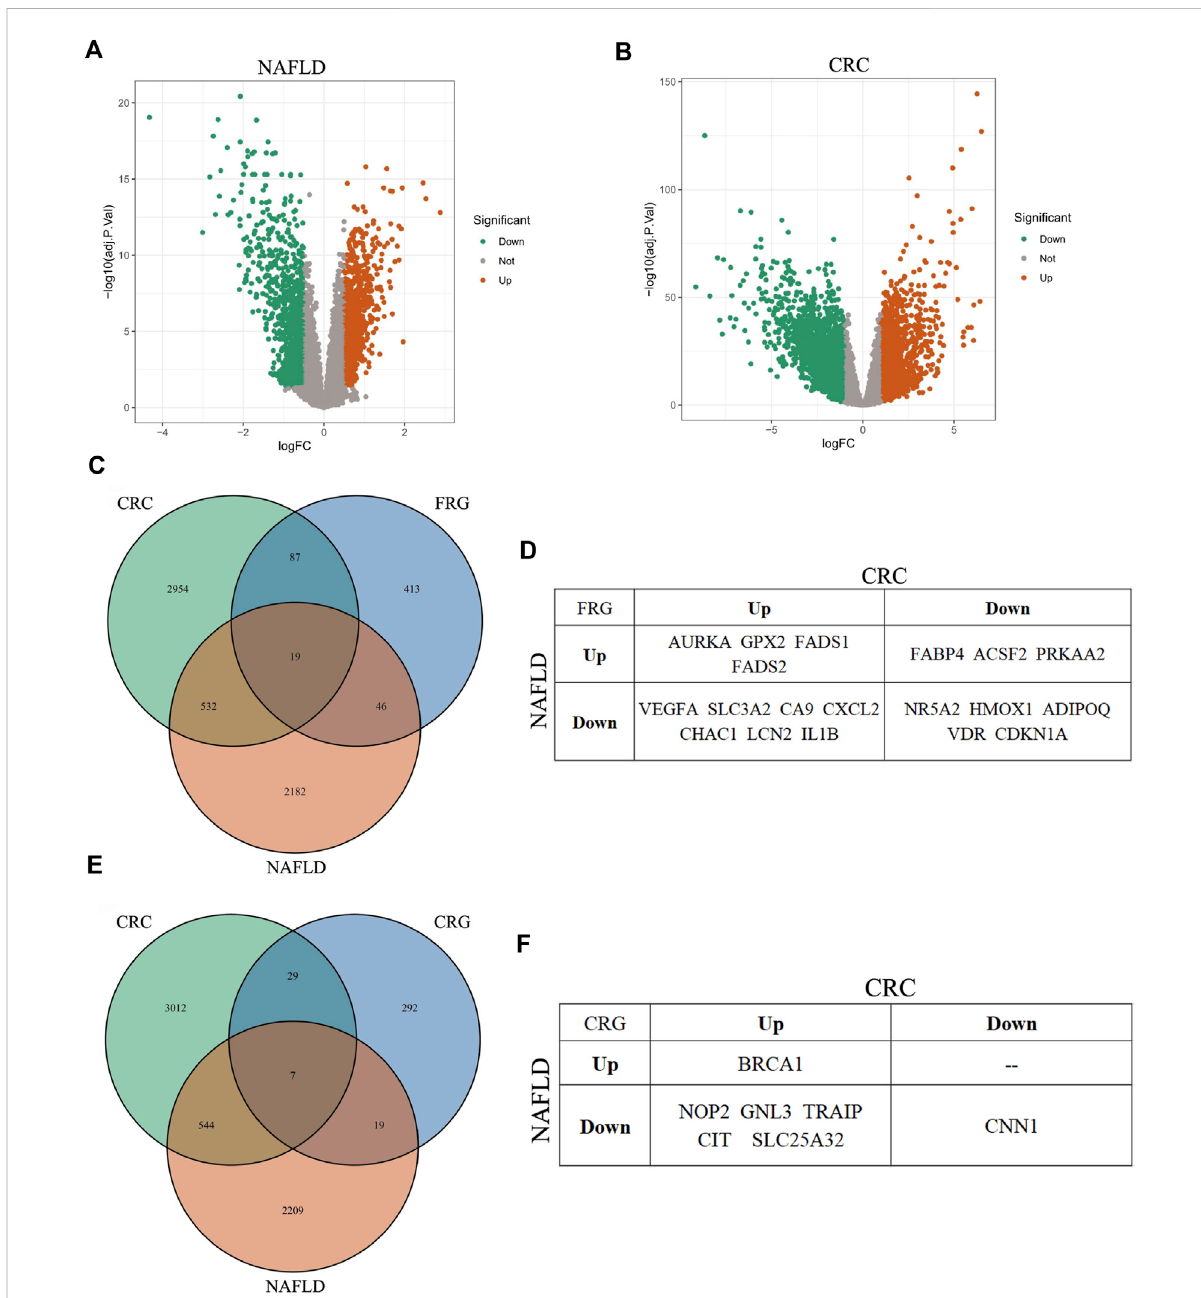
Analysis of DEGs in NAFLD, CRC, ferroptosis, and cuproptosis. (A,B) Volcano plot of DEGs in NAFLD and CRC, respectively. (C) Venn diagram of overlapping DEGs among NAFLD, CRC, and ferroptosis, respectively. (D) The overlapping DEGs among all the three gene sets: NAFLD, CRC, and ferroptosis. (E) Venn diagram ofoverlapping DEGs among NAFLD, CRC, and cuproptosis, respectively. (F) The overlapping DEGs among all the three gene sets: NAFLD, CRC, and